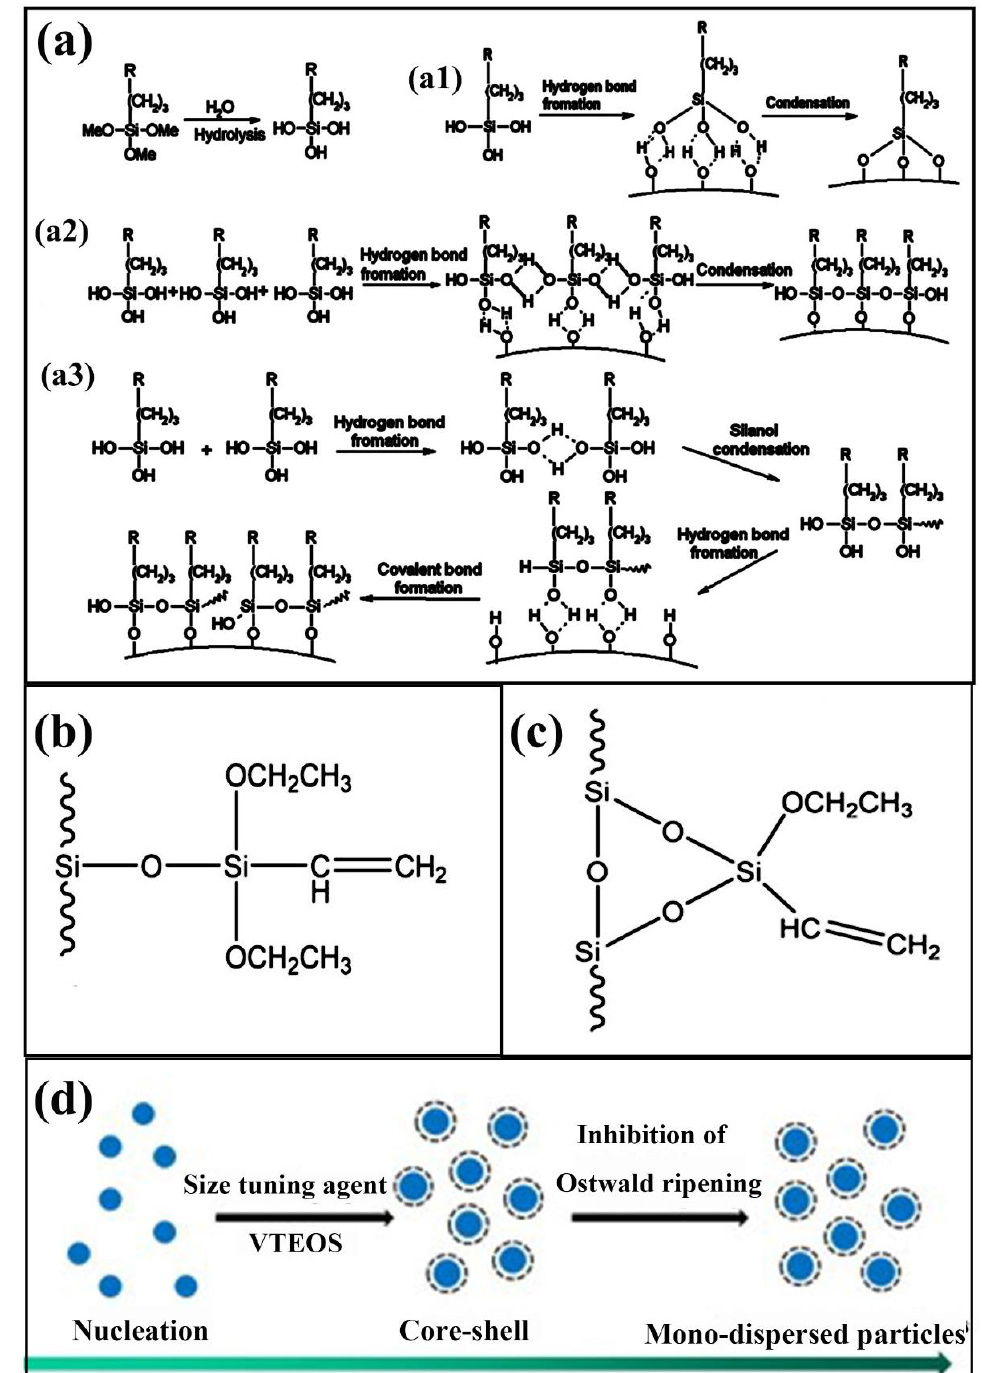
Figure 3. Legend of silane coupling agent grafting SNs. ( a ) Three possible mechanisms for grafting reaction between MPS and SNs ( a1 – a3 ). Adapted with permission from [26]. Copyright 2015, Elsevier. ( b , c ) Two connection types of coupling agent VTEOS. Adapted with permission from [132]. Copyright 2021, Royal Society of Chemistry. ( d ) Schematic diagram of VTEOS size adjustment mechanism. Adapted with permission from [133]. Copyright 2012, Elsevier.